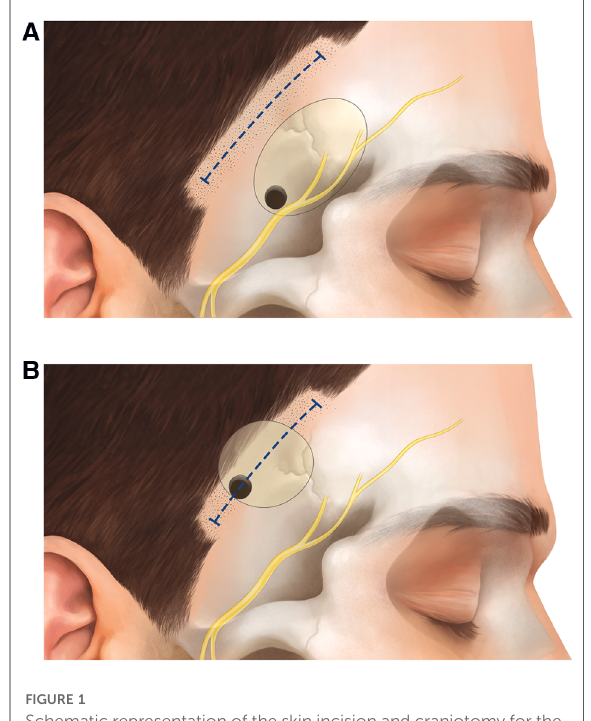
FIGURE 2 Schematic representation of the muscle incision/preparation for the ( A ) MPT and the ( B )